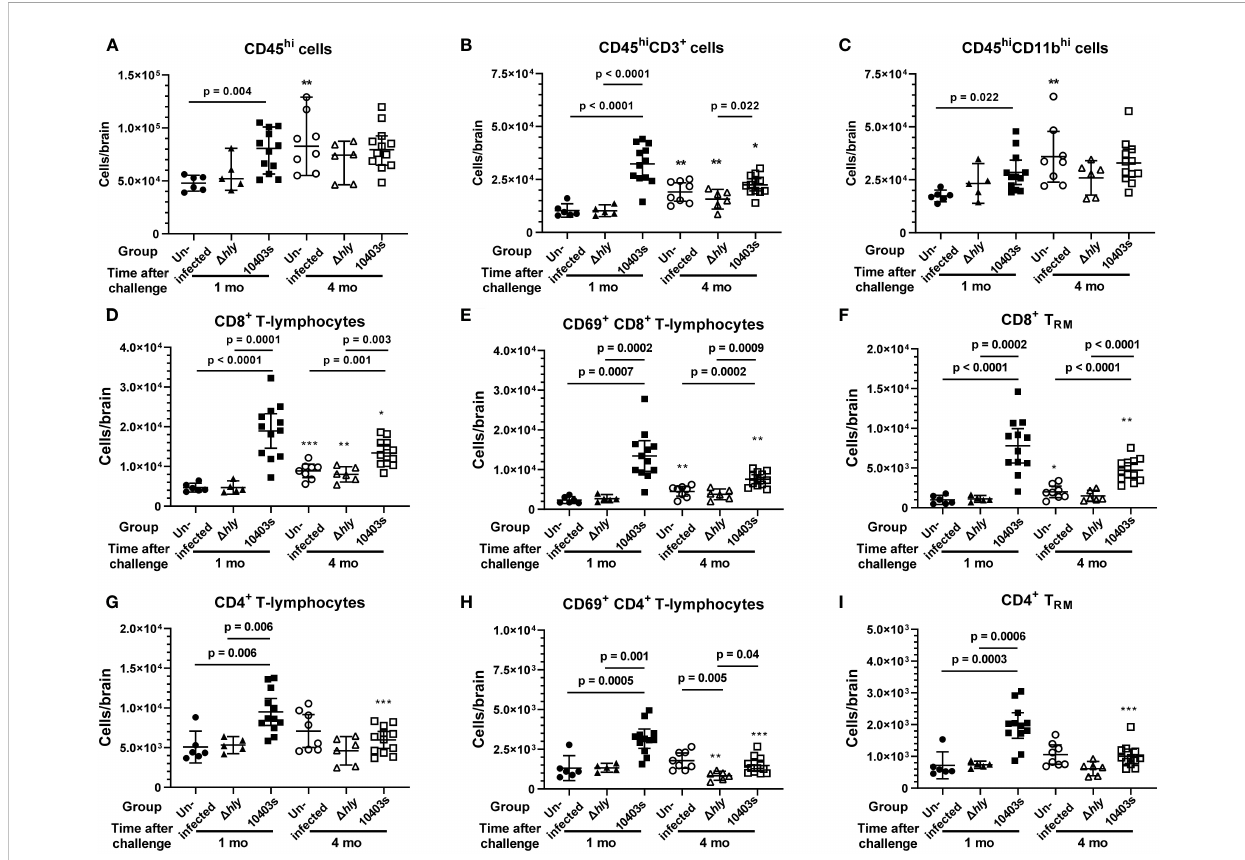
FIGURE 6 Analysis of bone marrow-derived leukocytes in brains of mice 1 and 4 mo after injection with neurovirulent Lm or avirulent D hly mutants. Brain leukocytes were collected from uninfected mice ( ● , ○ ) and from mice infected with Lm D hly mutants ( ▲ , D ) and Lm 10403s ( ■ , □ ) described in Figure 1 at 1 and 4 mo after infection, along with additional mice from the same treatment cohorts for which cognitive data were not collected. Leukocytes were collected from perfused brains and analyzed by fl ow cytometry and are shown as total CD45hi cells (A) , total lymphocytes (B) , total myeloid cells (C) , CD8+ lineage lymphocytes (D – F) , and CD4+ positive lineage lymphocytes (G – I) . Symbols indicate individual mice and lines represent group mean +/- 95% CI. Numbers of samples analyzed 1 mo and 4 mo after infection, respectively, are uninfected (6, 8), Lm D hly infected (5, 6), and Lm 10403s infected (12, 12). Signi fi cance within time points were calculated via 1-way ANOVA with Tukey ’ s post-test are given. Signi fi cance between the same challenge groups at 1 and 4 mo were calculated via 2-tailed Student ’ s t -test. *p < 0.05, **p < 0.01, ***p <